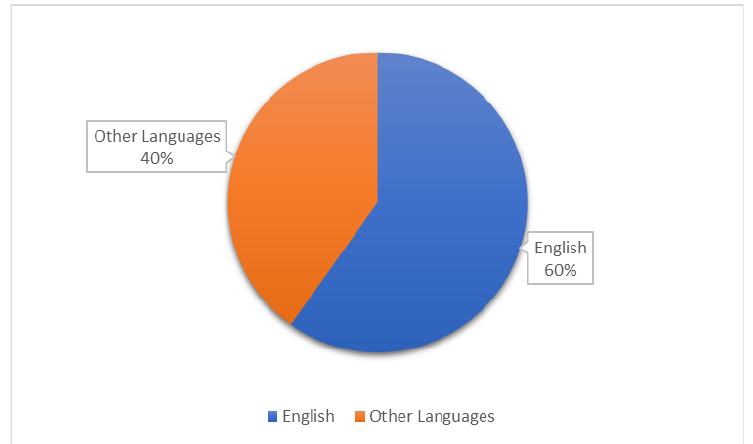
Figure 8. Distributions of Instagram comments from the perspective of English and non-English languages .